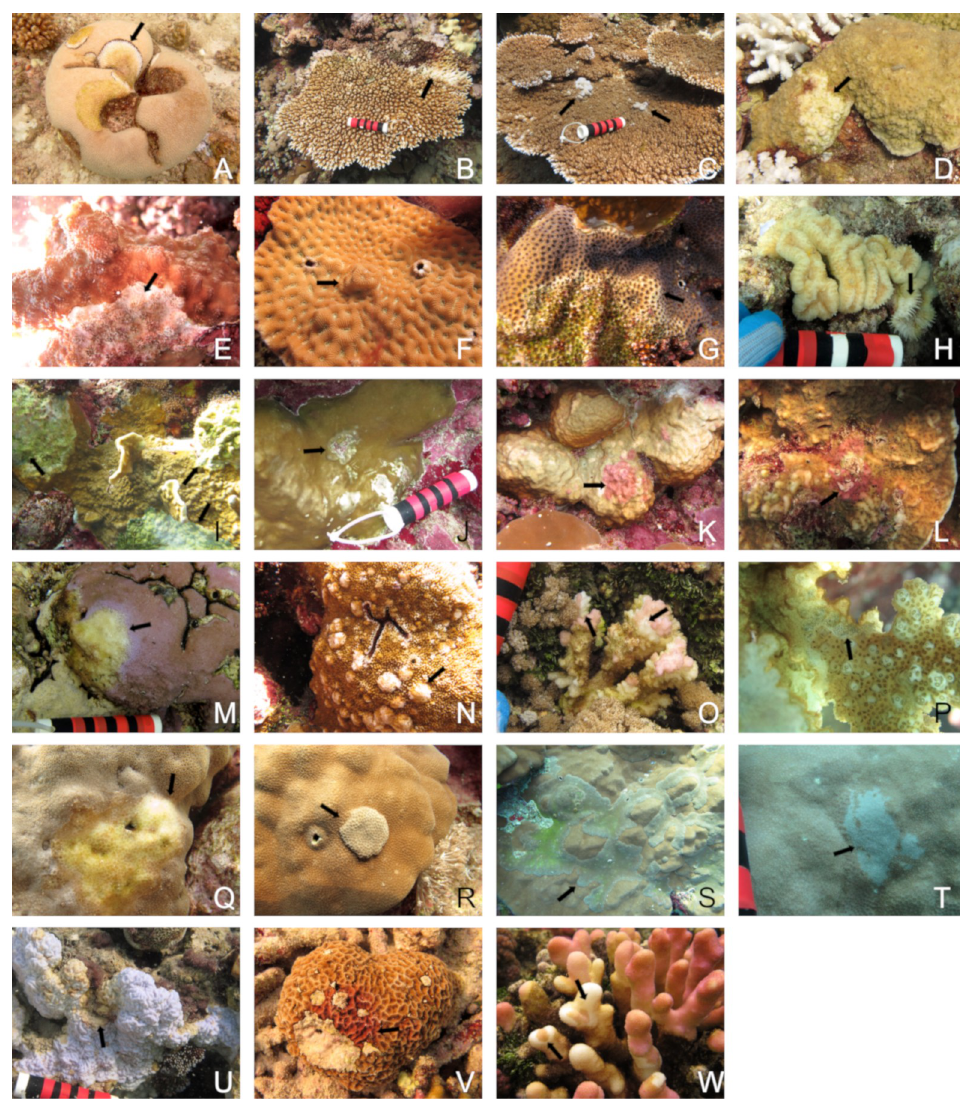
Fig 4. Examples of different coral diseases encountered during disease surveys along the Saudi coast of the Red Sea. WS = white syndrome, GA = growth anomaly, EH = endolithic hypermycosis, Bl = bleached. A) black band disease, B) Acropora WS, C) Acropora GA, D) Astreopora WS, E) Echinopora WS, F) Favites GA, G) Goniastrea WS, H) Lobophyllia WS, I) Millepora WS, J) Millepora GA, K) Millepora EH, L) Pavona EH, M) Montipora WS, N) Montipora GA, O) Pocillopora WS, P) Pocillopora SEB, Q) Porites WS, R) Porites GA, S) Porites GA, T) Porites Bl patch, U) Psammocora WS, V) Psammocora EH, W) Stylophora WS.